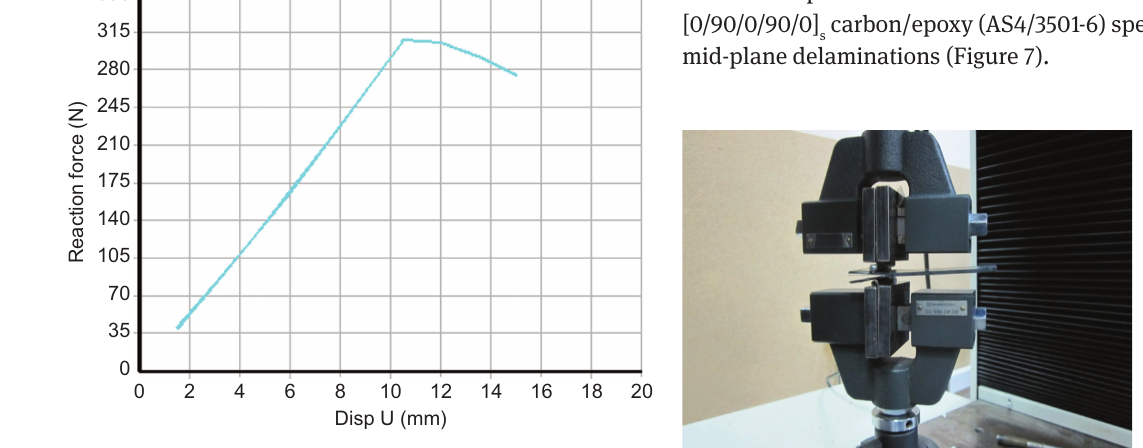
Figure 6 Force vs. displacement result of finite element analysis.